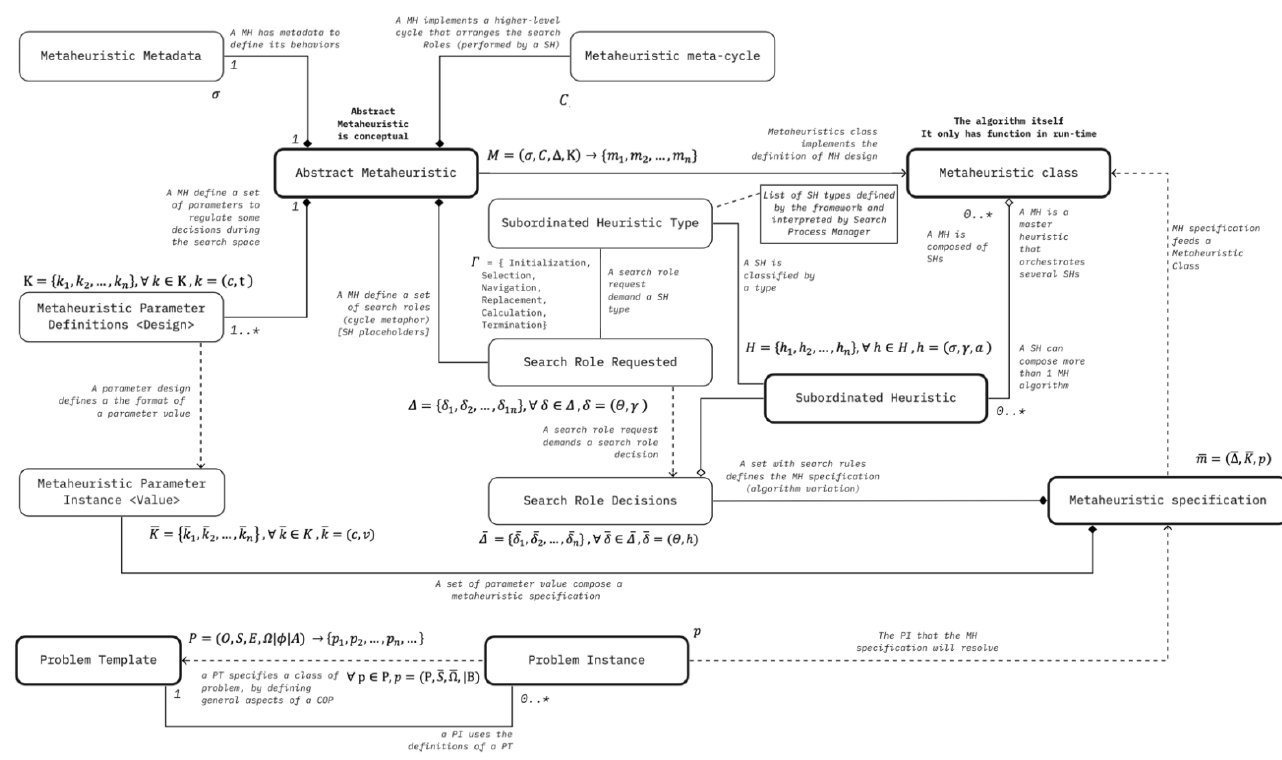
Figure 8 below synthetizes all metaheuristics definitions and their relationships. It is expressed in a higher-level class diagram.